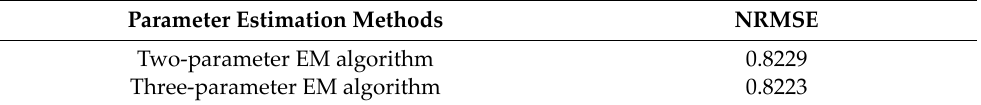
Table 2. Simulation of NRMSE results. Parameter Estimation Methods NRMSE Two‑parameter EM algorithm 0.8229 Three‑parameter EM algorithm 0.8223